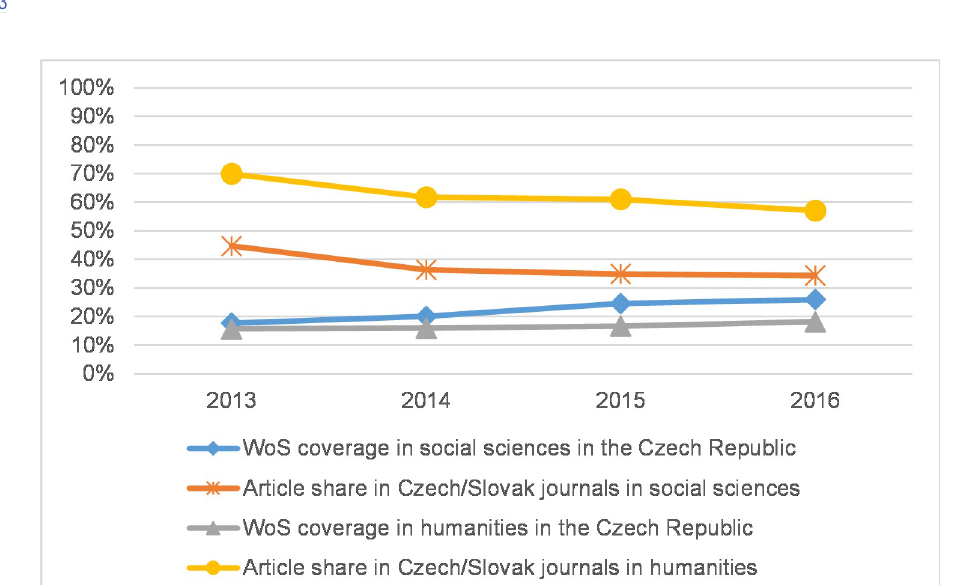
Fig 9. WoS coverage and regional journal article share in the Czech